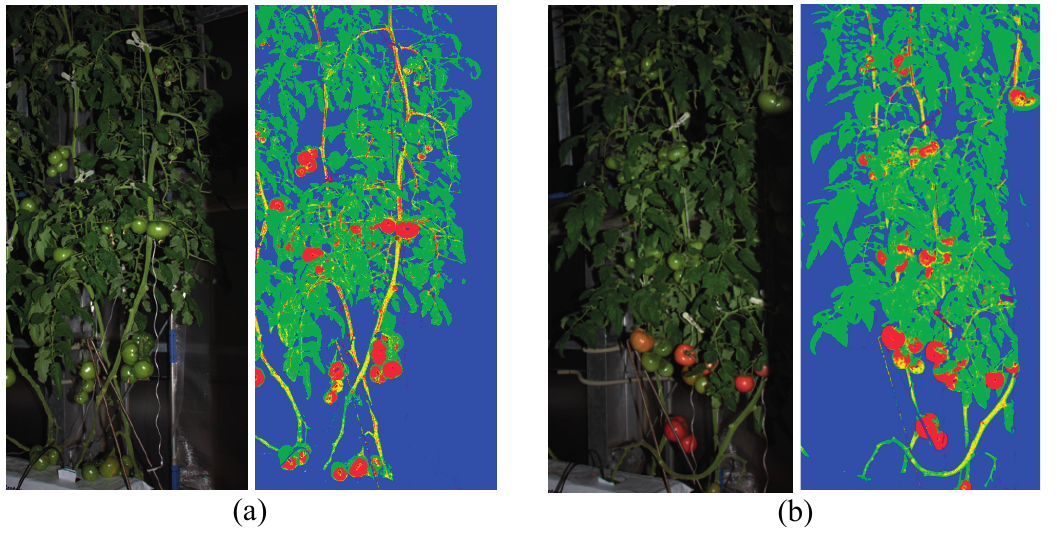
Figure 6. Examples of pixel-based segmentation. Left images show the original images. Right images show the result of the pixel-based segmentation. Pixels drawn with red, green, yellow, and blue colors are pixels classified into fruit, leaf, stem and background,